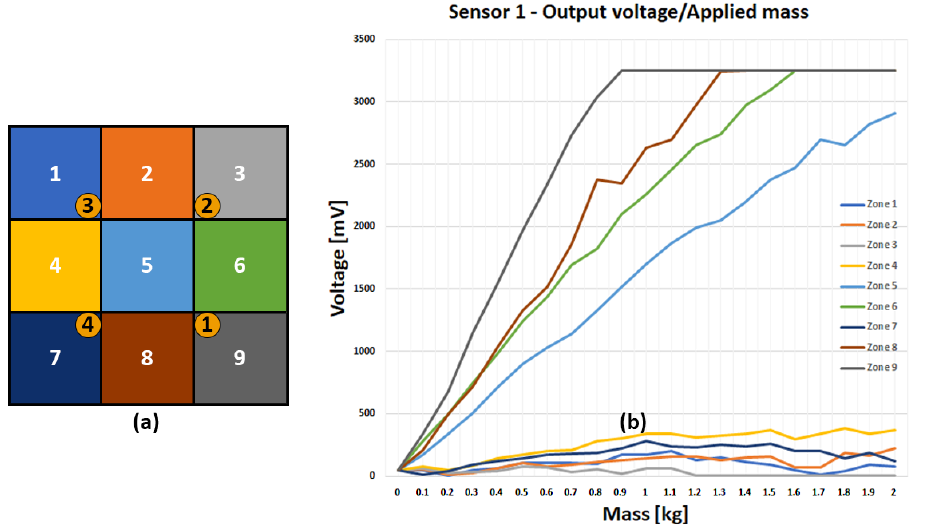
Figure 11. Representation of the smart tile, subdivided into nine zones ( a ). Measures of the analogue output voltage depending on mass and position ( b